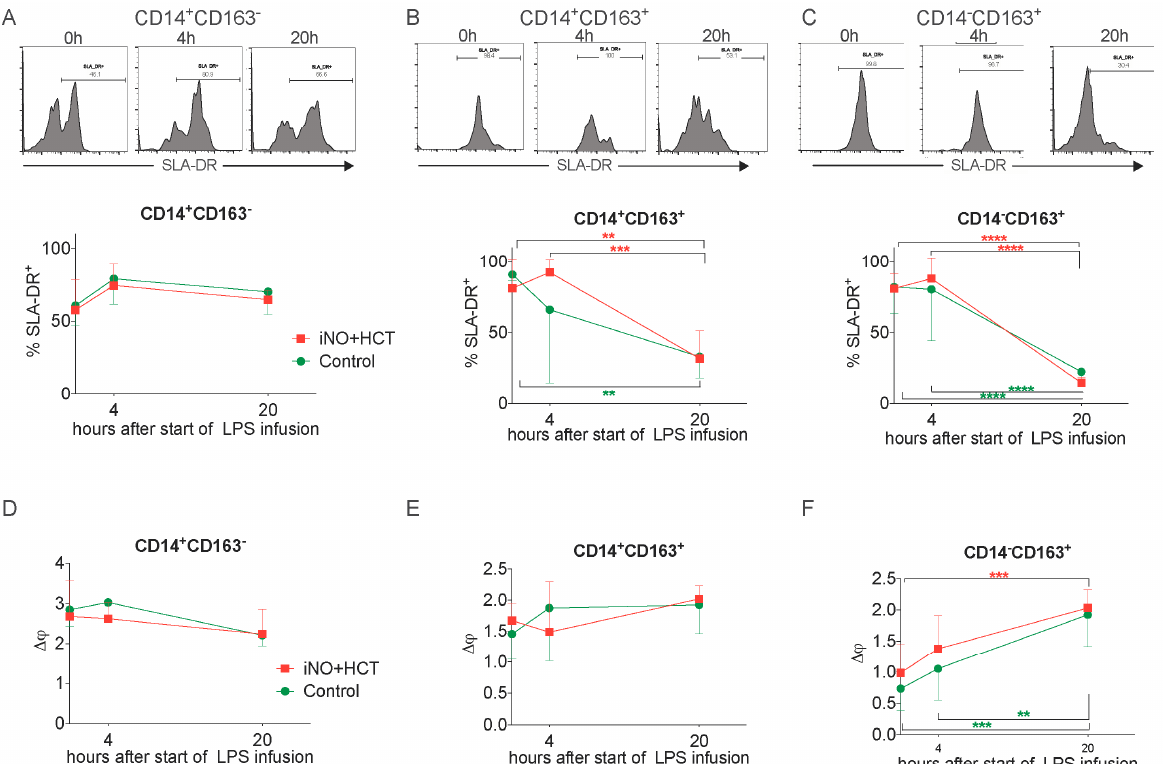
Figure 3. Effects of endotoxemia on the activation status of circulating monocytes. The kinetics of SLA-DR expression on subpopulations of circulating blood monocytes with representative histograms from flow cytometry analysis is shown: ( A ) CD14 + CD163 − monocytes, ( B ) CD14 + CD163 + monocytes, and ( C ) CD14 − CD163 + monocytes. The mitochondrial membrane potential ( ∆ ϕ ) was analyzed using JC-1 staining followed by flow cytometric analysis on: ( D ) CD14 + CD163 + monocytes, ( E ) CD14 + CD163 + monocytes, and ( F ) CD14 + CD163 − monocytes. Mean values ±SD are presented. Base- line, T4 h T8 h n = 9/group, T20 h n = 6/group. The statistical significance of differences between values at different timepoints for each group: ** p < 0.01, *** p < 0.001, **** p < 0.0001. SLA-DR swine